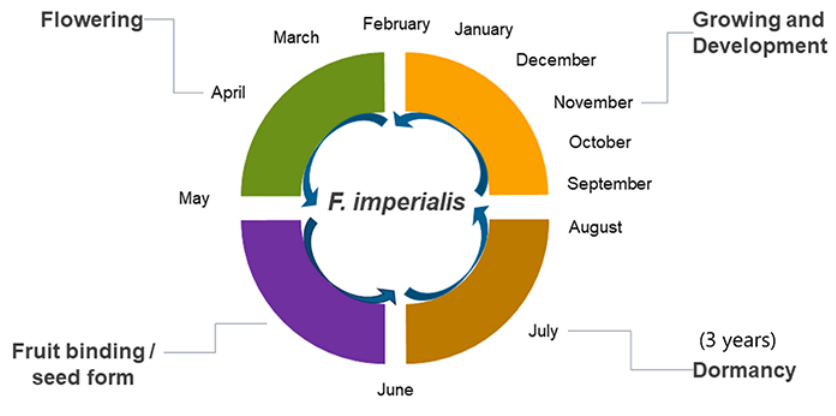
Figure 2 Vegetation period of Fritillaria imperialis [created based on Atay (1996) and Alp